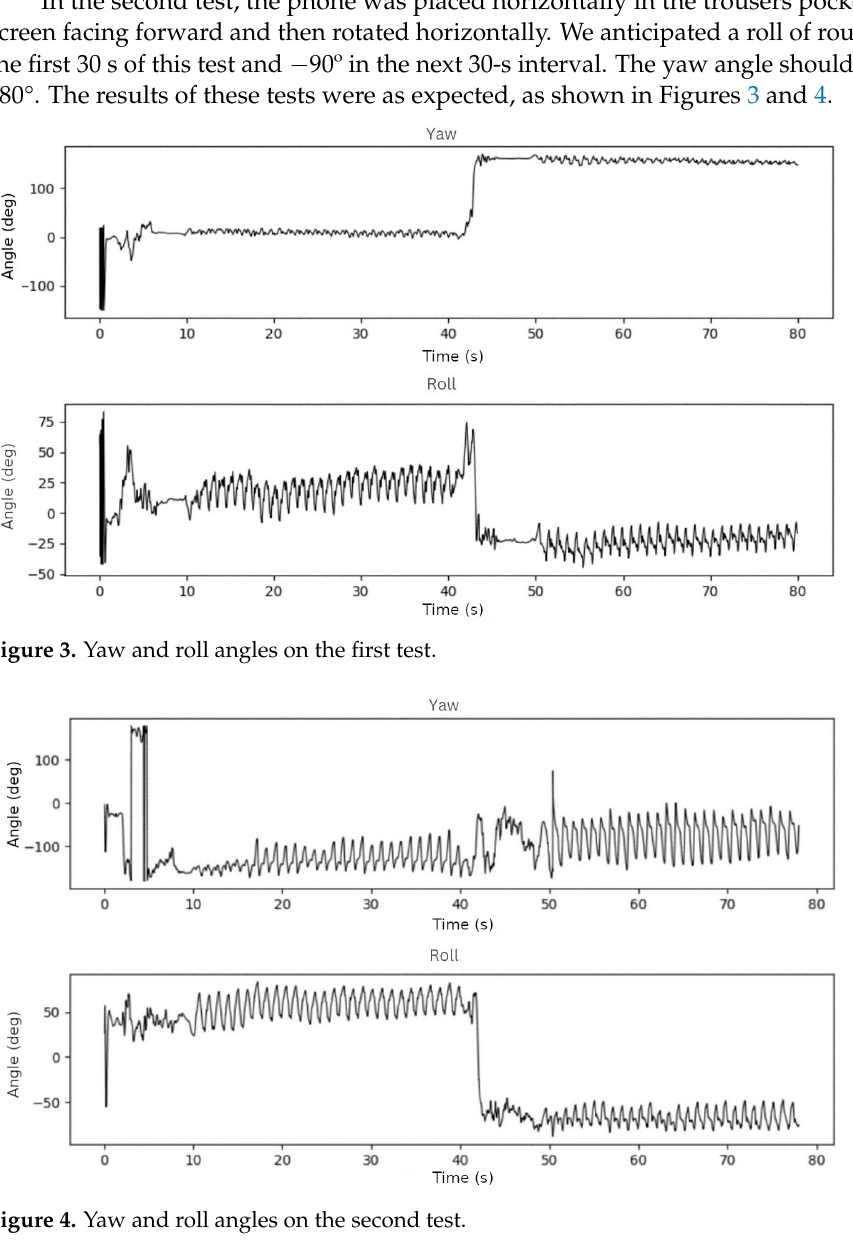
Figure 4. Yaw and roll angles on the second